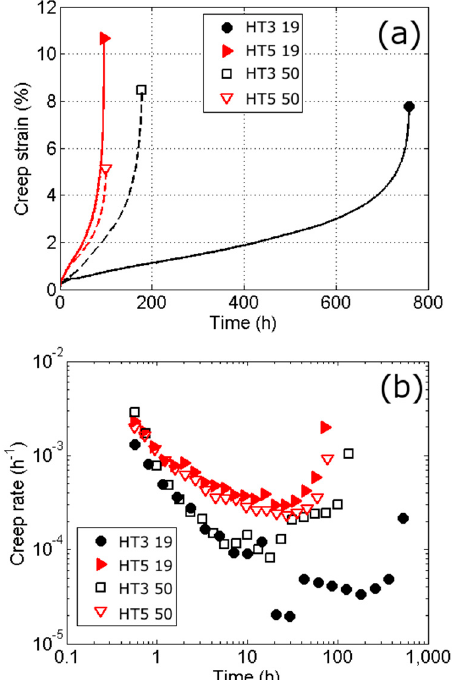
Figure 7. Constant load creep tests at 500 °C at stresses of 0.82 of the yield stress of HT3 at the elevated temperature, and for the different conditions. In ( a ) are the creep curves (plastic strain against time) and in ( b ) the creep rate curves.